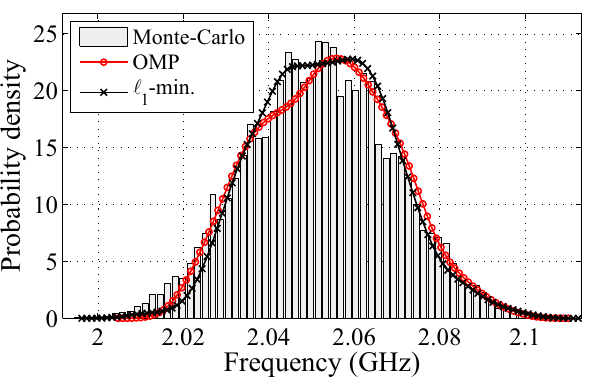
Figure 9: Probability-density functions of the 6-dB roll-off frequencies, in the case of the dielectric-stack